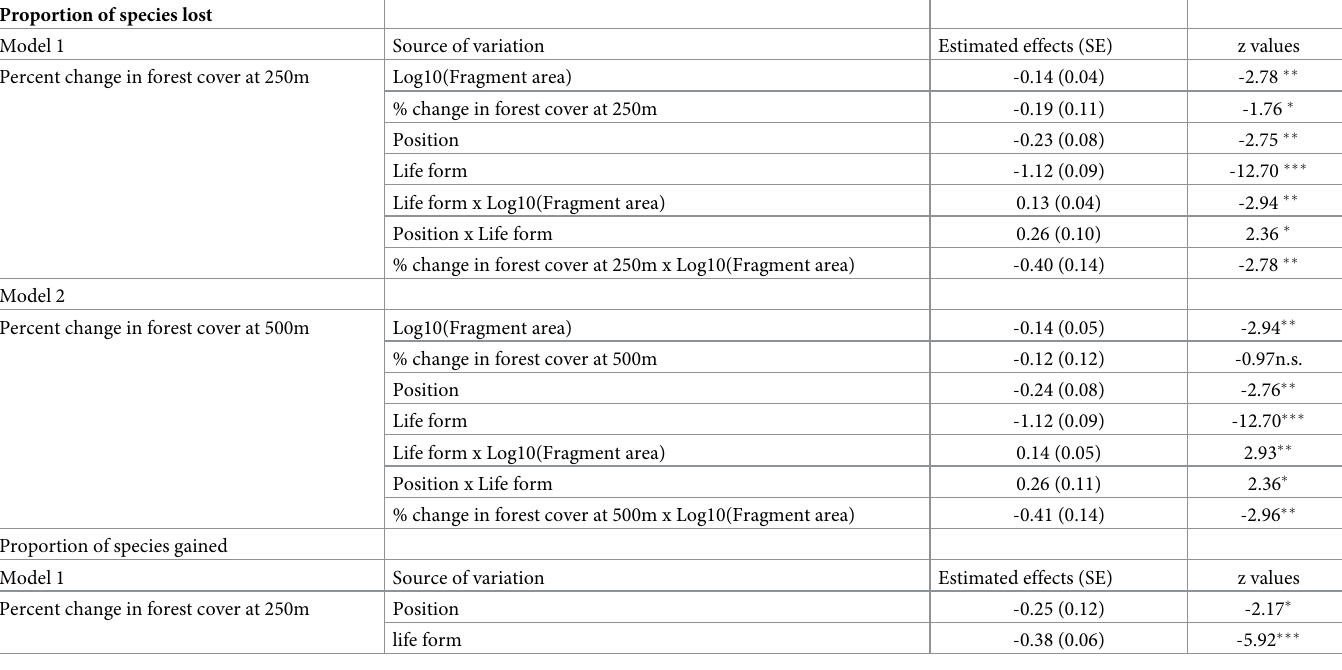
Table 3. Results of generalized linear mixed effects models on the proportion of species lost and gained. Effects of fragment area, percent change of surrounding forest cover at 250m and 500m, life form (woody and non-woody), position (edge-interior), and year (2003–2013) on the proportion of lost and gained species in 18 Chaco Ser- rano forest fragments. We report the effects and z values estimated from the reduced model. Reduced models for the proportion of gained species were similar considering forest cover at 250m and 500m and only results at 250m are shown. No interaction was observed at 1000m for lost and gained species, thus we do not show these